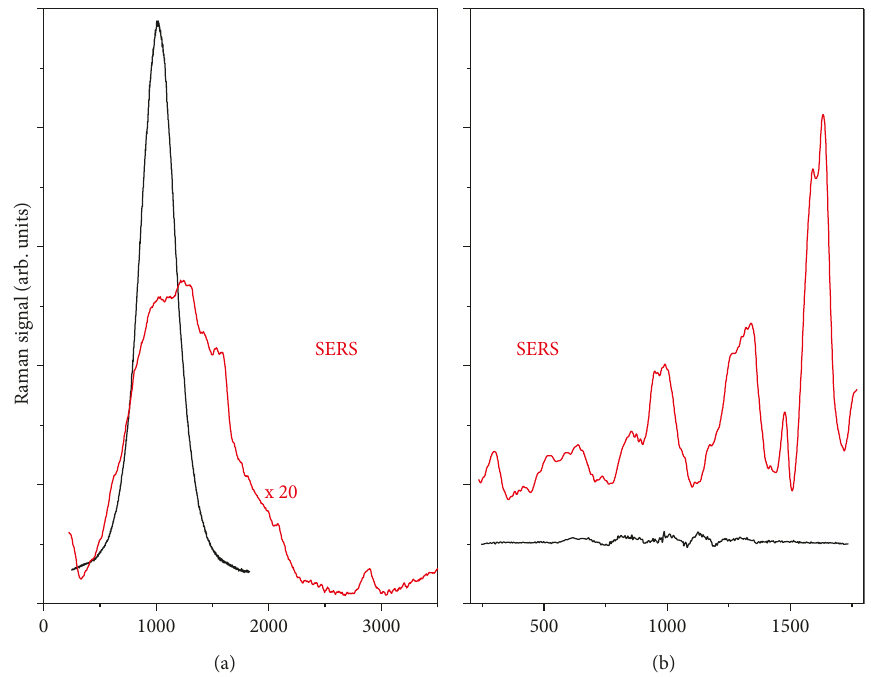
Figure 2: EVOO Raman signal measured by conventional micro-Raman spectroscopy (black lines) and SERS signal (red lines). In (a) panel, the raw data (SERS signal is reported magnified 20 times with respect to Raman signal) are reported and in (b) panel, the elaborated signals are shown. An acquisition time of 8s has been used for the Raman signal and 300s for